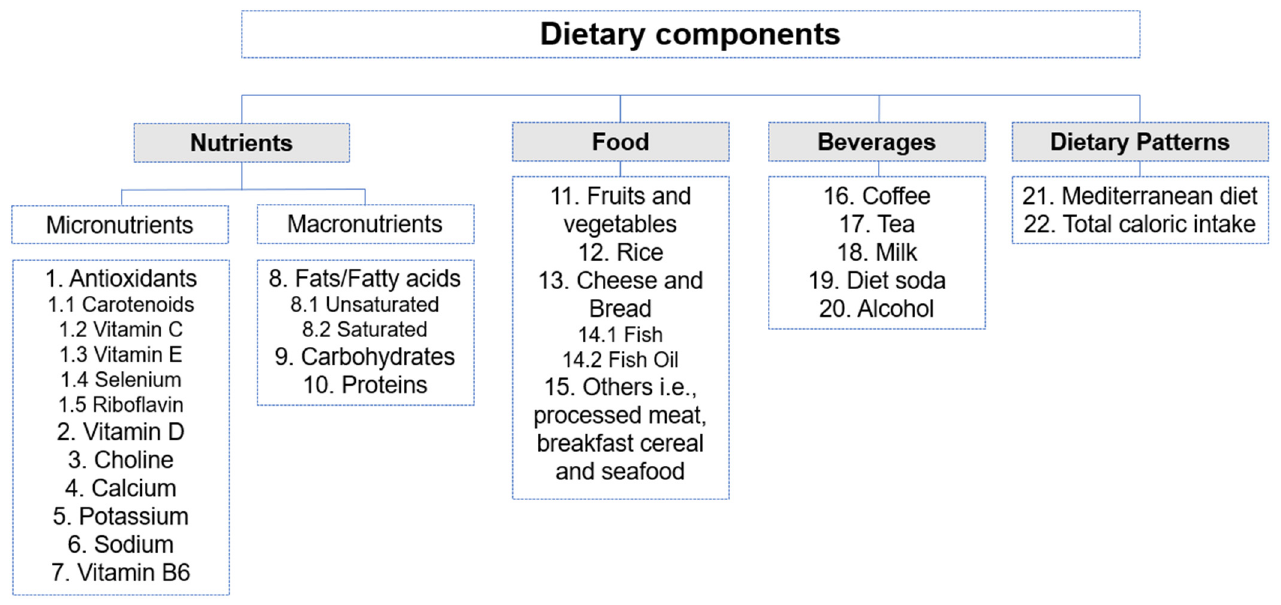
Figure 3. An overview of dietary components based on the studies included in the systematic review. The number assigned to the dietary component corresponds to the results section for easy referencing.